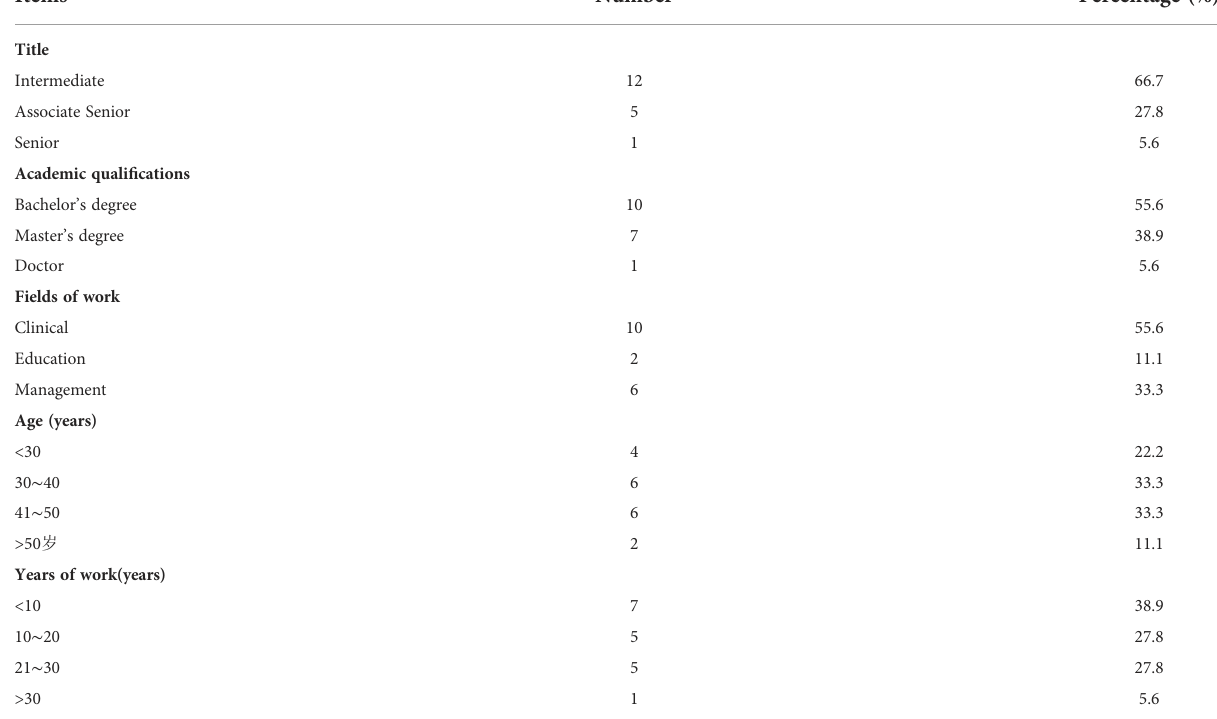
TABLE 2 Basic information on the 18 experts included in this